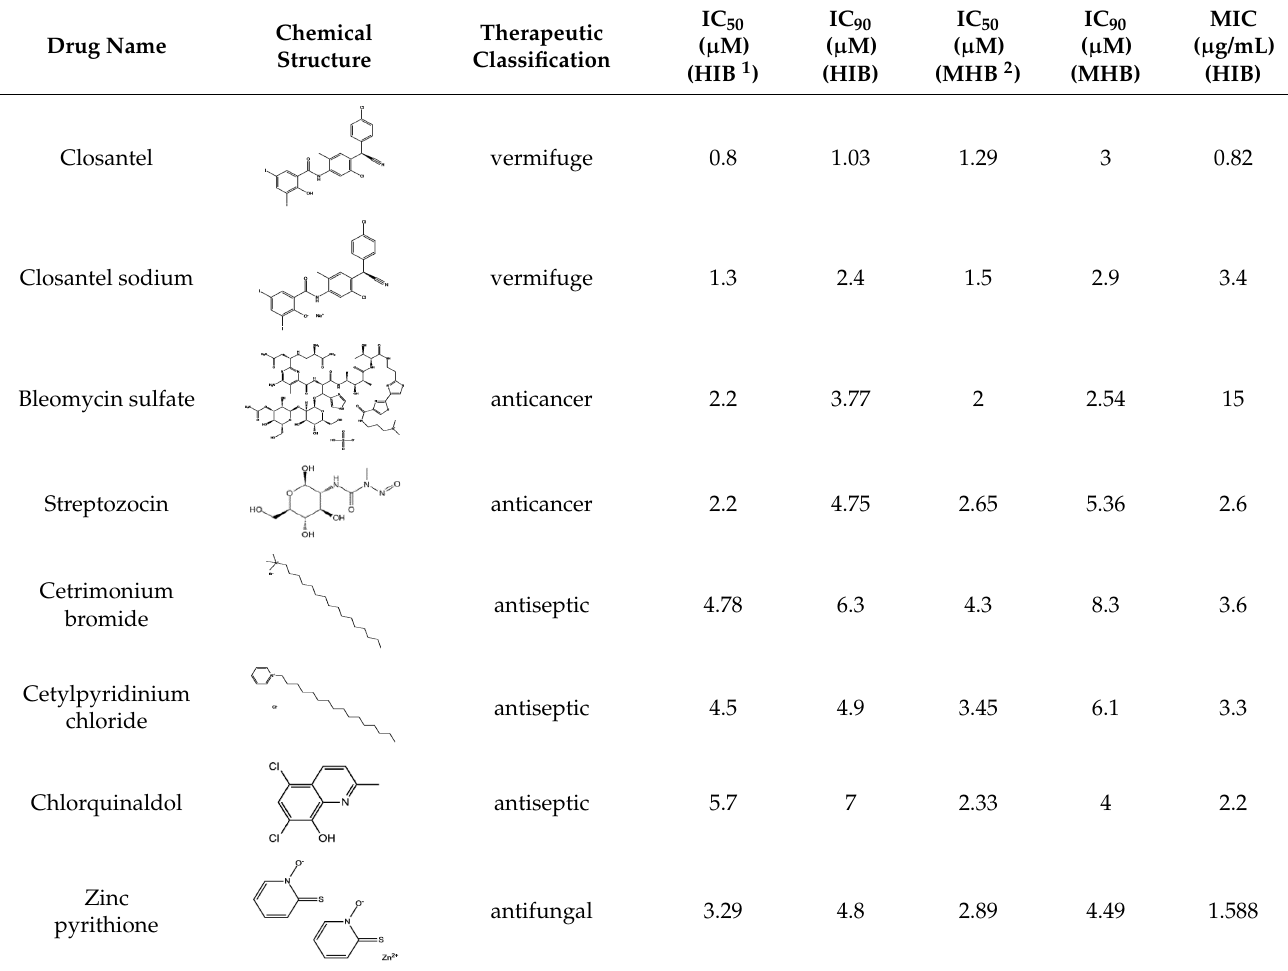
Table 2. Novel potential antiplague Table 2. Novel potential antiplague drugs. Table 2. Novel potential antiplague drugs. Table 2. Novel potential antiplague drugs. Table 2. Novel potential antiplague drugs. Table 2. Novel potential antiplague drugs. Table 2. Novel potential antiplague drugs. Table 2. Novel potential antiplague drugs. Table 2. Novel potential antiplague drugs.